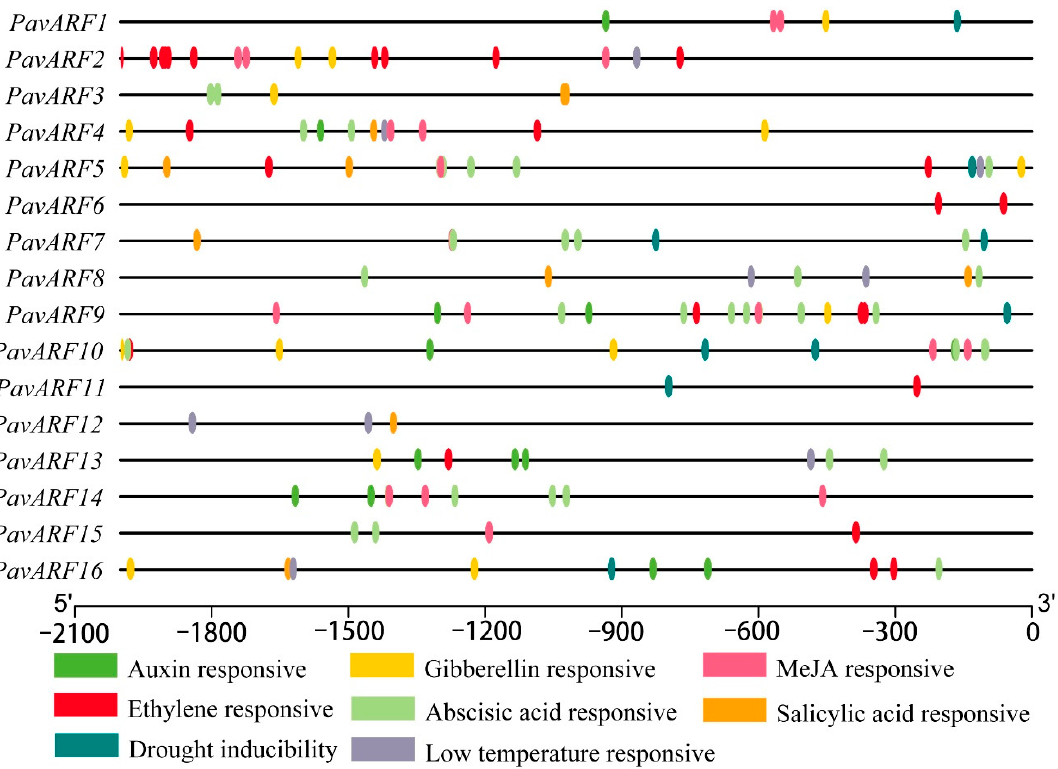
Figure 3. Analysis of specific cis -elements in PavARF promoters. The 2000 bp upstream sequences were used to analyze six specific phytohormone-related cis-elements (auxin, gibberellin, MeJA, ethylene, abscisic acid and salicylic acid), two stress-responsive regulatory elements including drought and low-temperature. They are illustrated by the different color boxes.